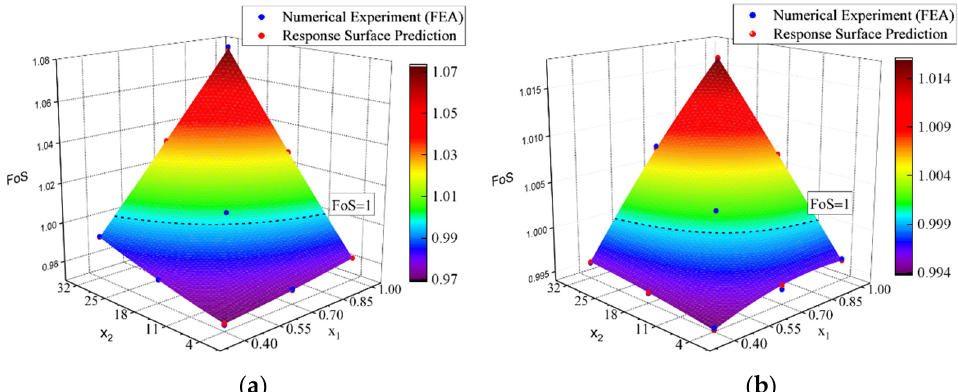
Figure 16. Generated response surface from a polynomial fit to the CCD data points for ( a ) compressive and ( b ) shear buckling.